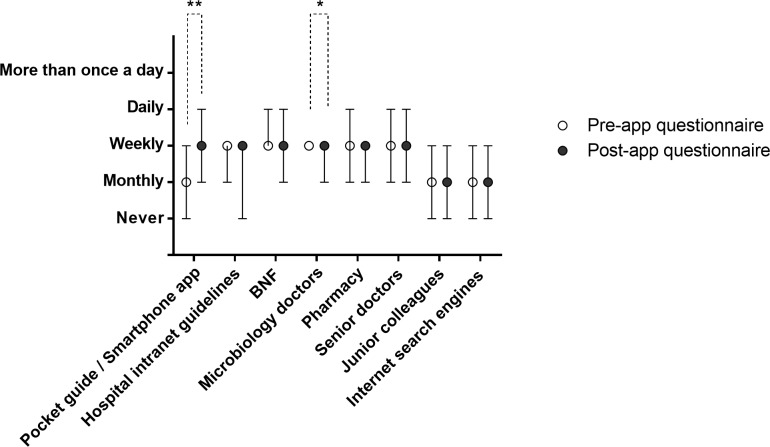
Use frequency of antimicrobial prescribing guidelines before and after introduction of the smartphone app.In the first group, pre-app questionnaire data relate to frequency of use of the pocket guide, whereas post-app questionnaire data relate to frequency of use of the smartphone app. Each data point denotes median frequency of responses and error bars represent interquartile range of frequency of responses. **—denotes smartphone app used more frequently than pocket guide (p < 0.01 by Mann-Whitney test). *—denotes microbiology doctors’ advice used less frequently after introduction of the smartphone app (p < 0.05 by Mann-Whitney test).